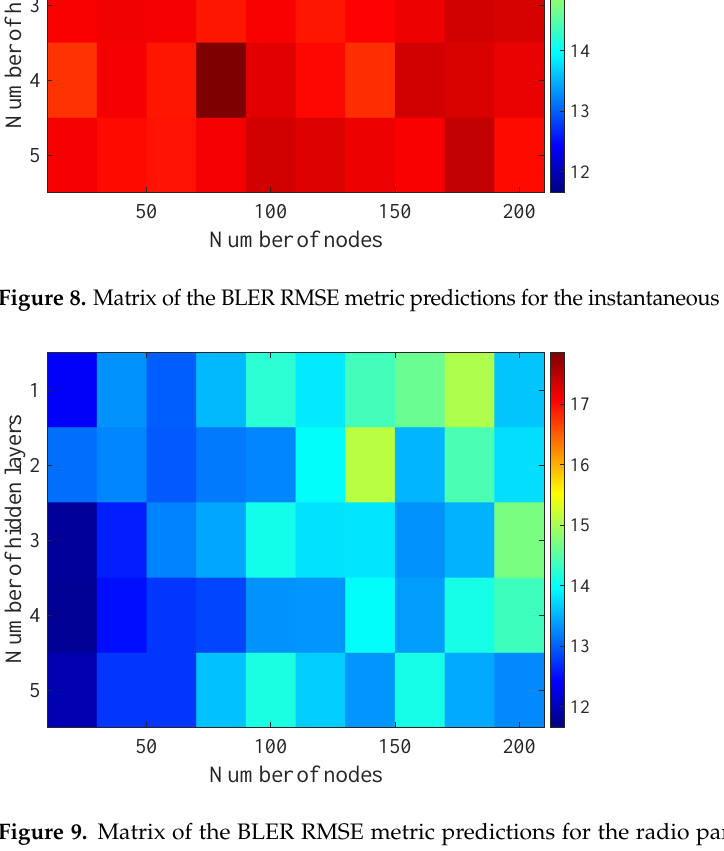
Figure 9. Matrix of the BLER RMSE metric predictions for the radio parameters history window W =